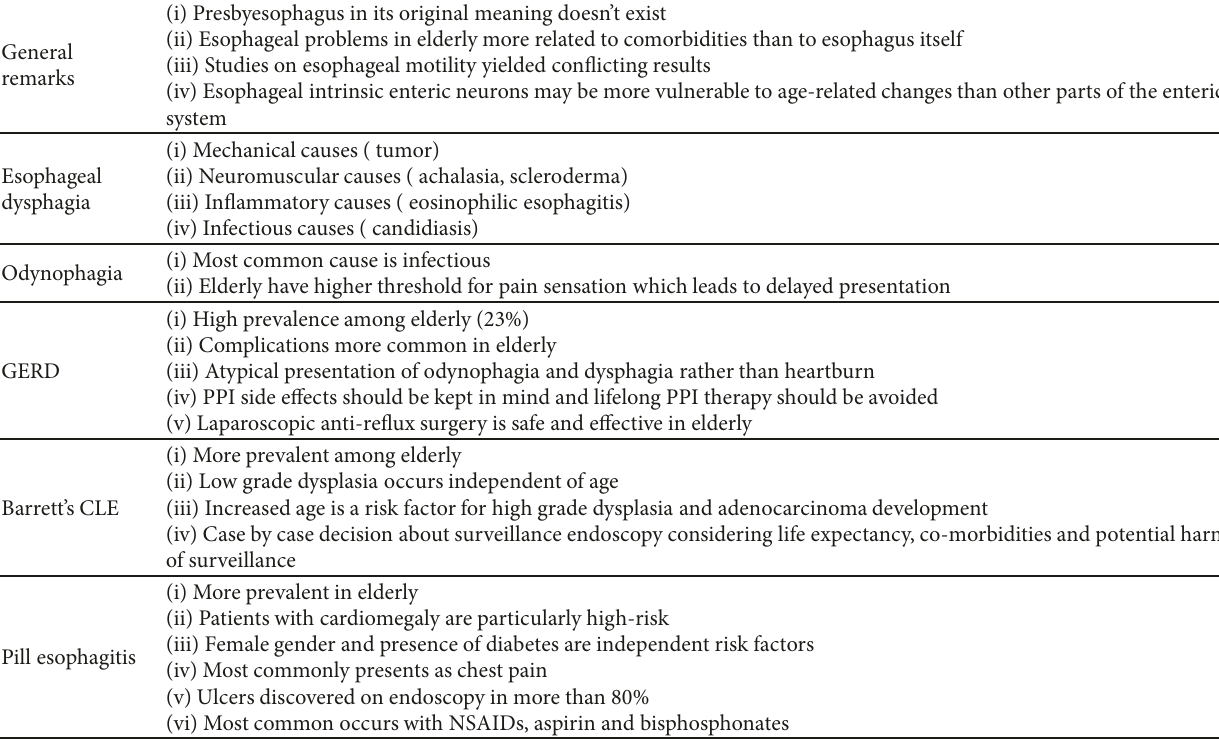
Table 2: Esophageal disease characteristics in older